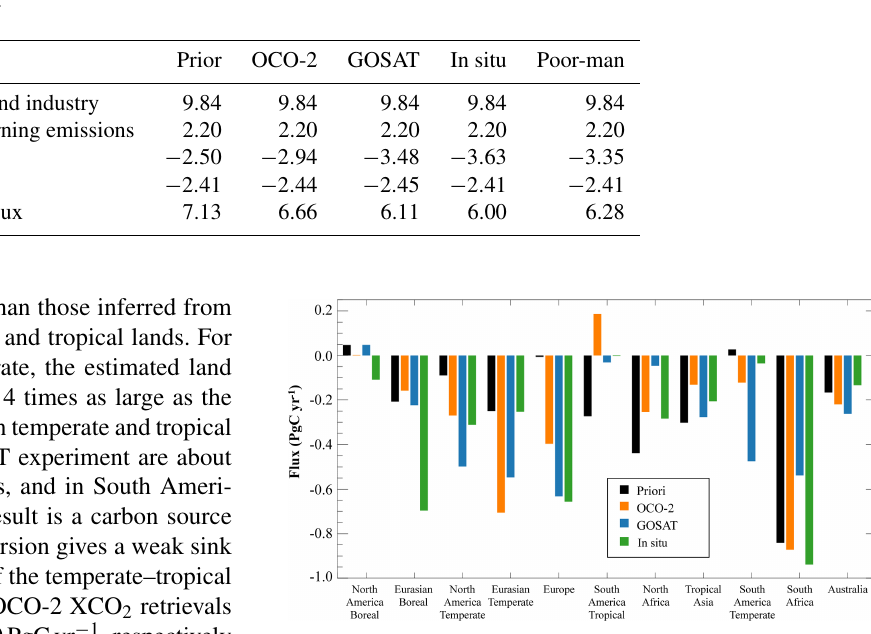
Figure 6. Aggregated annual land fluxes of the 11 TRANSCOM land regions. Table 3. The prior and posterior fluxes on six continents and in boreal, temperate and tropical lands (PgCyr − 1 )